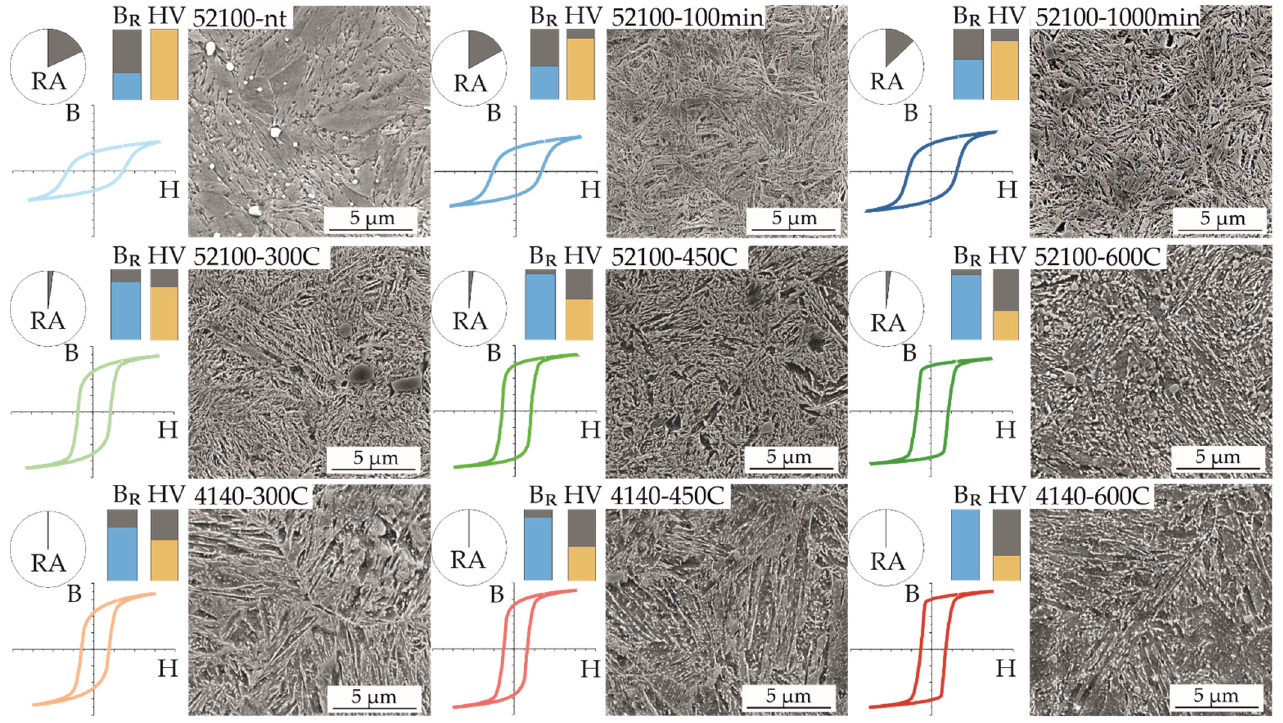
Figure 5. Retained austenite content RA, magnetic remanence B R, and hardness HV 30 in relation to the respective maximum recorded values, magnetic hysteresis in the color scheme of Figure 1, and SEM images with a 15,000× magnification of all specimens.